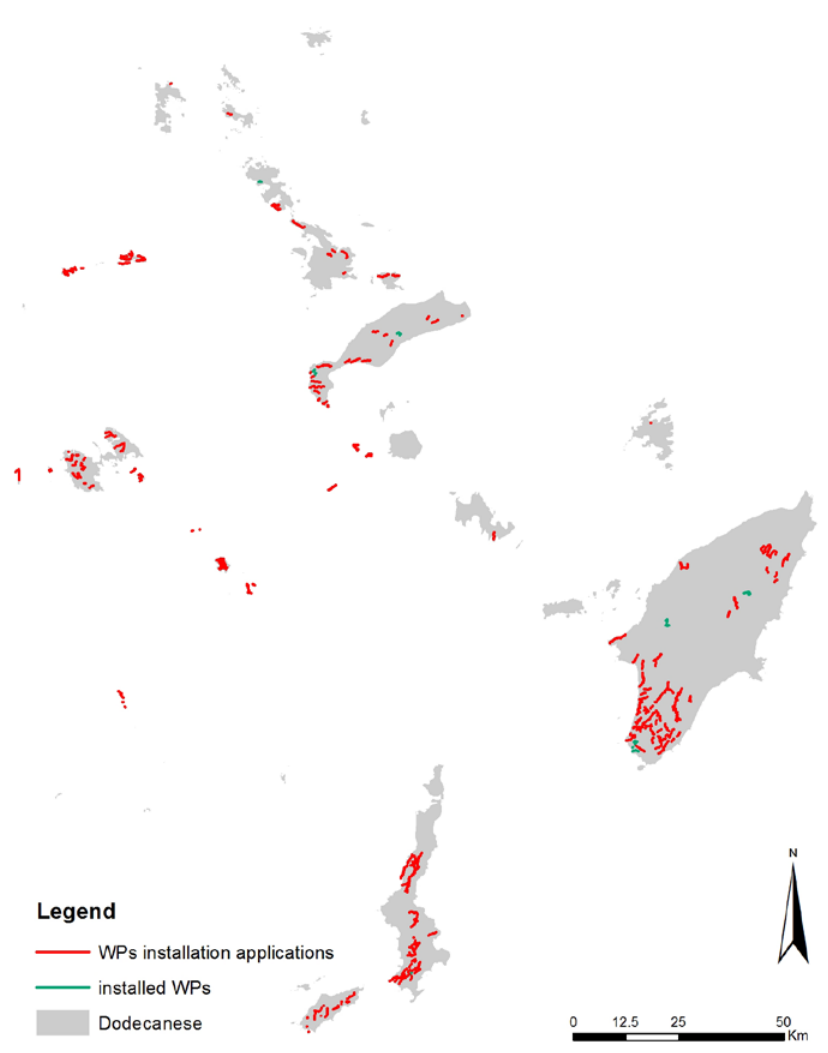
Figure 9. Installed WPs and WPs installation applications for the Dodecanese.